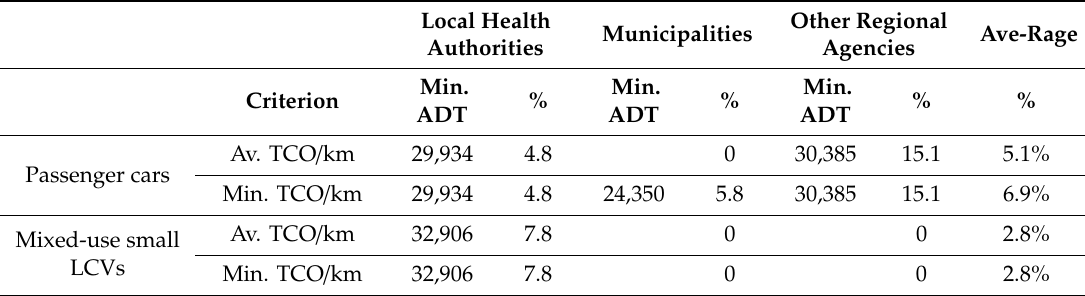
Table 6. Percentage of passenger cars and mixed-use small LCVs that if battery electric vehicles (BEVs) would have a lower TCO / km: Scenario A status quo.